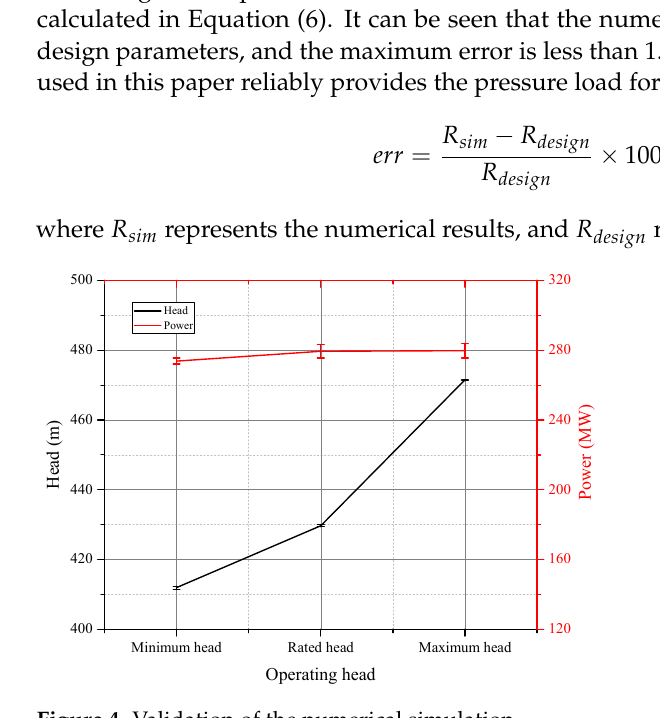
Figure 4. Validation of the numerical simulation.